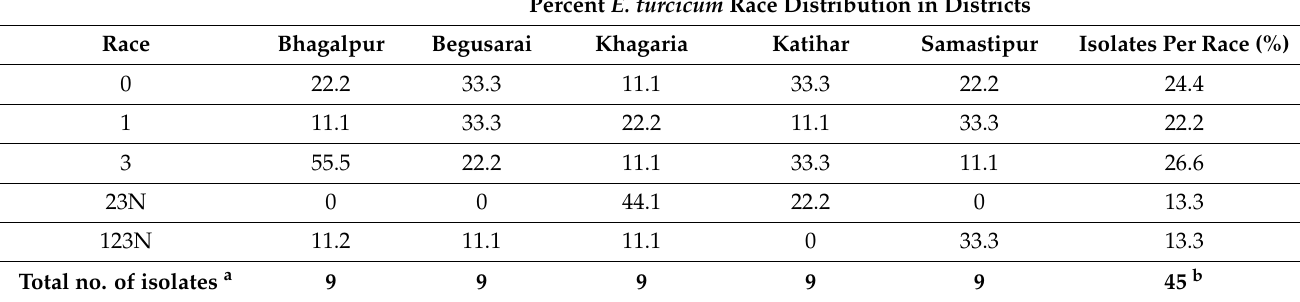
Figure 5. Disease reaction of E. turcicum race 0 on differential line ‘6′ after 14th days of inoculation. All five races were present in each of the five districts (Bhagalpur, Begusarai, Khagaria, Katihar and Samastipur) of Bihar except race 23N was absent in Bhagalpur, Begusarai and Samastipur whereas, race 123N was absent in Katihar district. Race 3, race 0, and race 1 were the most commonly observed races with 24.4%, 22.2% and 26.6% frequency of the total isolates tested, respectively. Race 3 was the predominant race in Bhagalpur and Katihar, whereas race 0 was predominant in Begusarai and Katihar and race 1 was predominant in Begusarai and Samastipur. Race 23N was predominant in Khagaria and race123N was predominant in Samastipur (Table 3). Table 3. Frequency of E. turcicum isolates of each race found in different